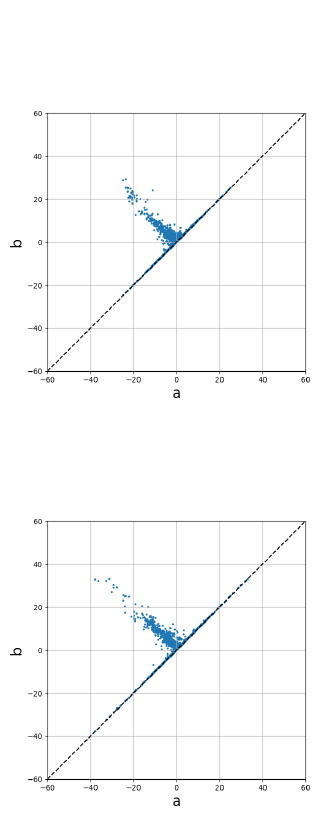
Figure A7. Tense passenger with SAV